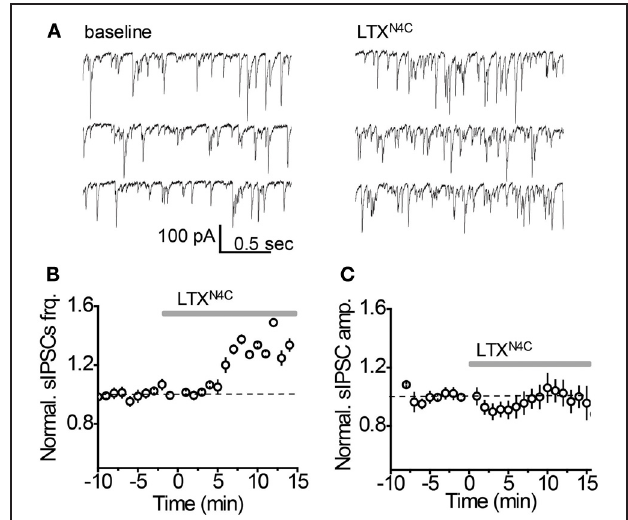
FIGURE 5 | LTX N4C enhances spontaneous synaptic GABA release. (A) Representative whole-cell recordings of sIPSC from an individual CA1 str. radiatum interneuron before ( left ) and 10min after ( right ) focal application of LTX N4C . (B) LTX N4C effect on the mean sIPSC frequency normalized to the baseline (dashed line , n = 7). Gray line —application of LTX N4C . ( C) LTX N4C effect on mean sIPSC amplitude normalized to the baseline (dashed line, n = 7). Gray line —application of LTX N4C